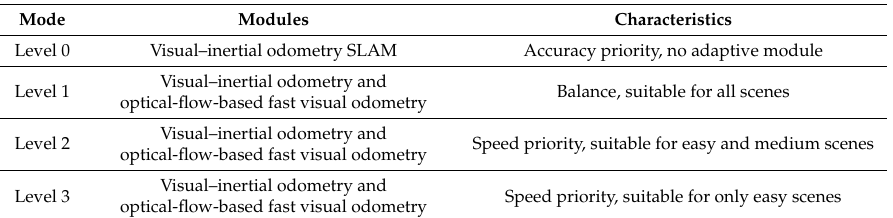
Table 2. Table of adaptive execution policies.